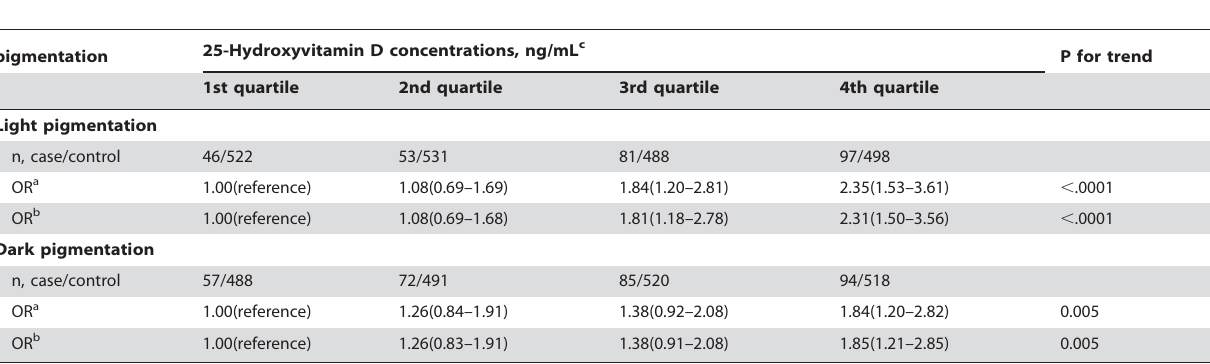
(Table 4). In the stratified analysis by UVB flux, women who lived in lower UVB flux ( # 113) areas tended to have higher Table 6. Odds ratios of BCC by quartile of plasma vitamin D concentrations in NHS and NHS II (stratified by pigmentation).